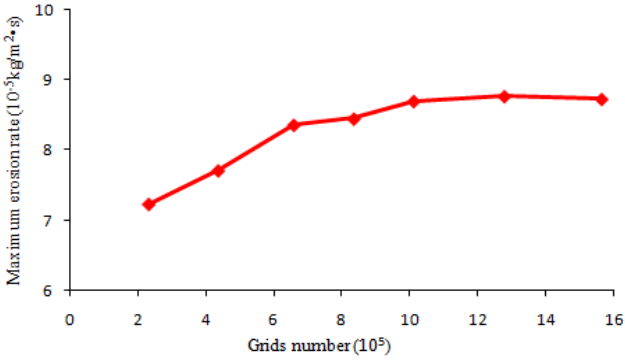
Figure 4. Maximum erosion rate with different numbers of grids.